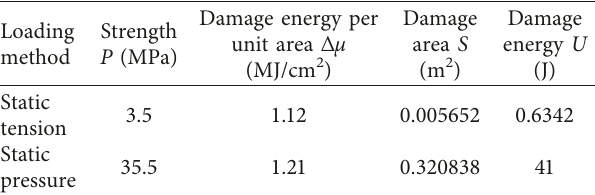
Figure 18: The failure of the specimen under dynamic tension loading. Table 1: The damage area and damage energy for samples sub- jected to static pressure and static